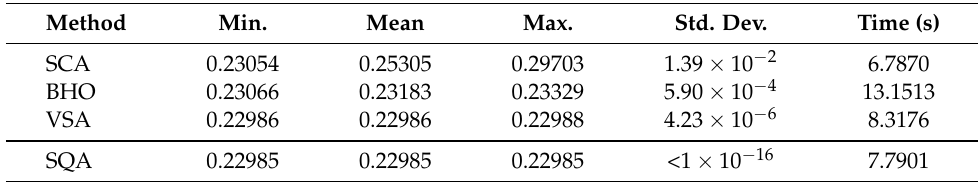
Table 6. Evaluation of the different alternatives to solve the OPF problem in bipolar asymmetric DC networks (all values in